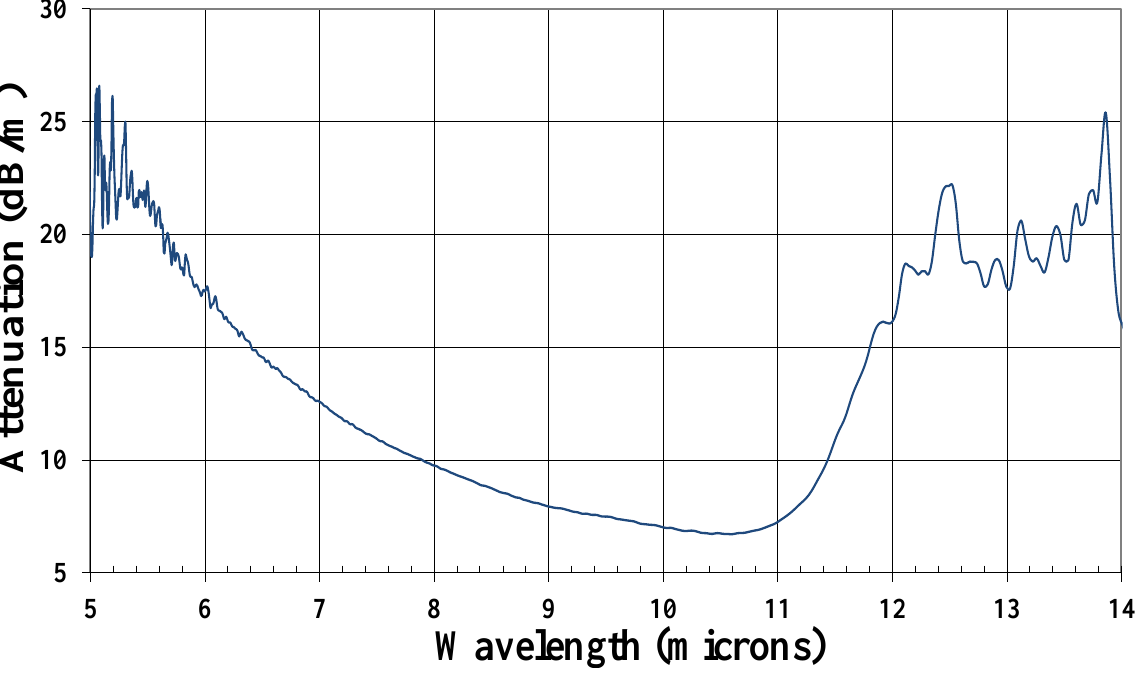
Figure 3. Attenuation curve of a Ge 10–11